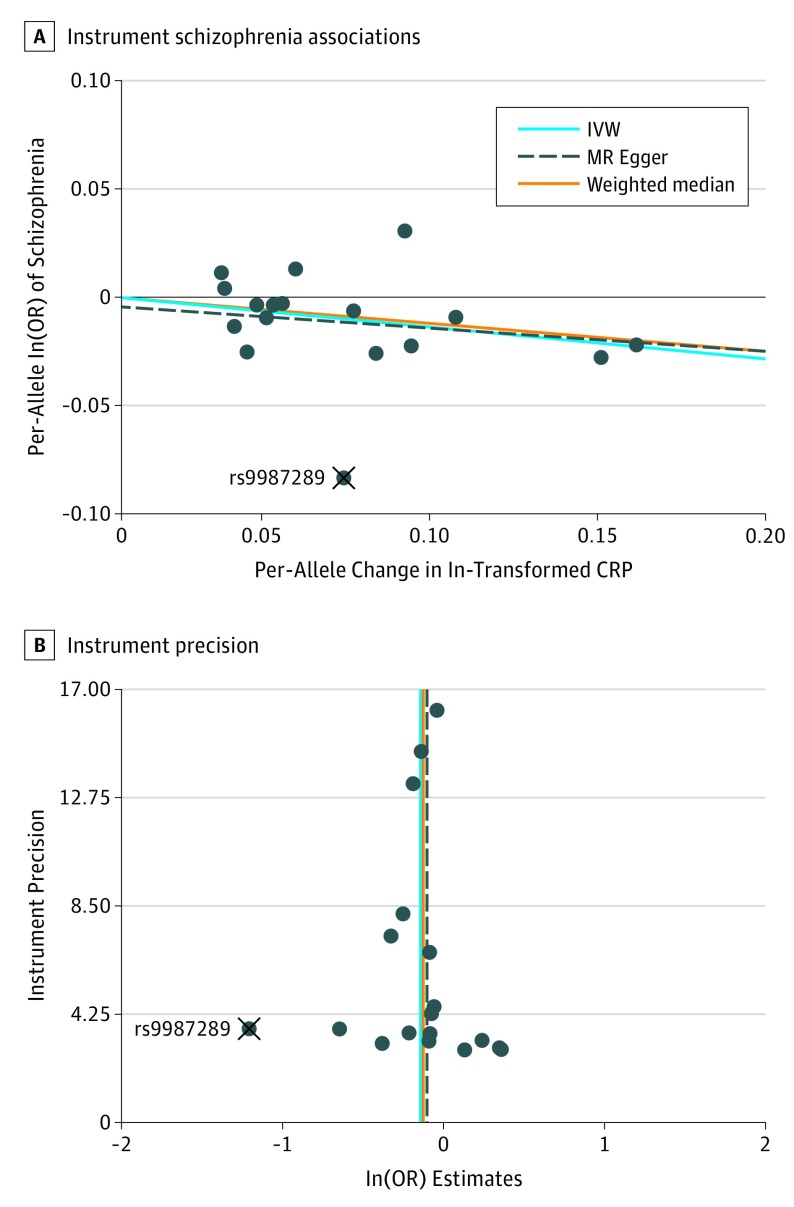
Mendelian Randomization (MR) Analyses Regarding the Effect of C-Reactive Protein (CRP) Levels on Schizophrenia Using the Liberal Set of 18 Genetic InstrumentsA, Instrument schizophrenia associations (y-axis) against instrument CRP associations (x-axis). B, Instrument precision (ie, instrument CRP regression coefficients divided by the correspondent instrument schizophrenia SEs) (y-axis) against individual instrument ratio estimates in log odds ratio of schizophrenia (x-axis). In(OR) indicates odds ratio estimate per 1-ln increment in biomarker levels; IVW, inverse variance weighting; X, the single genetic instrument classified as influential (rs9987289).